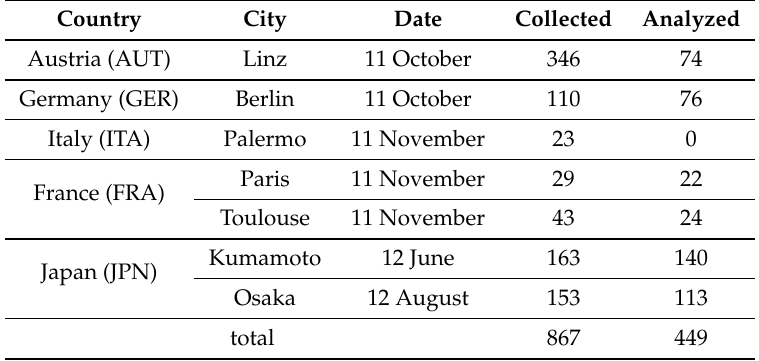
Table 1. Number of questionnaires collected and analyzed in each location. Country City Date Collected